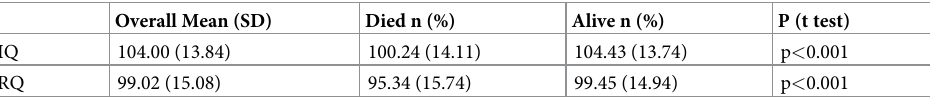
Table 2. Mean cognitive and behavioural